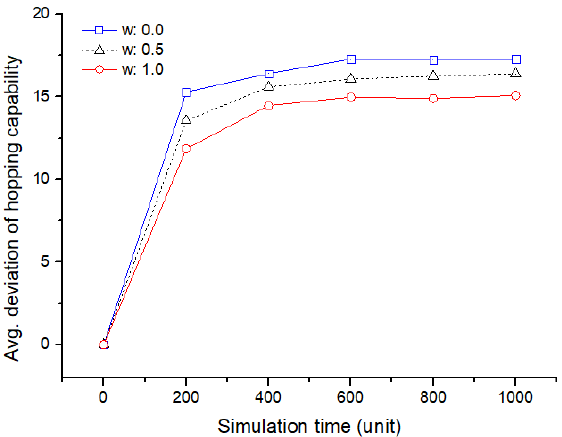
Figure 15. The average variance of hopping capability for a single sensing hole.